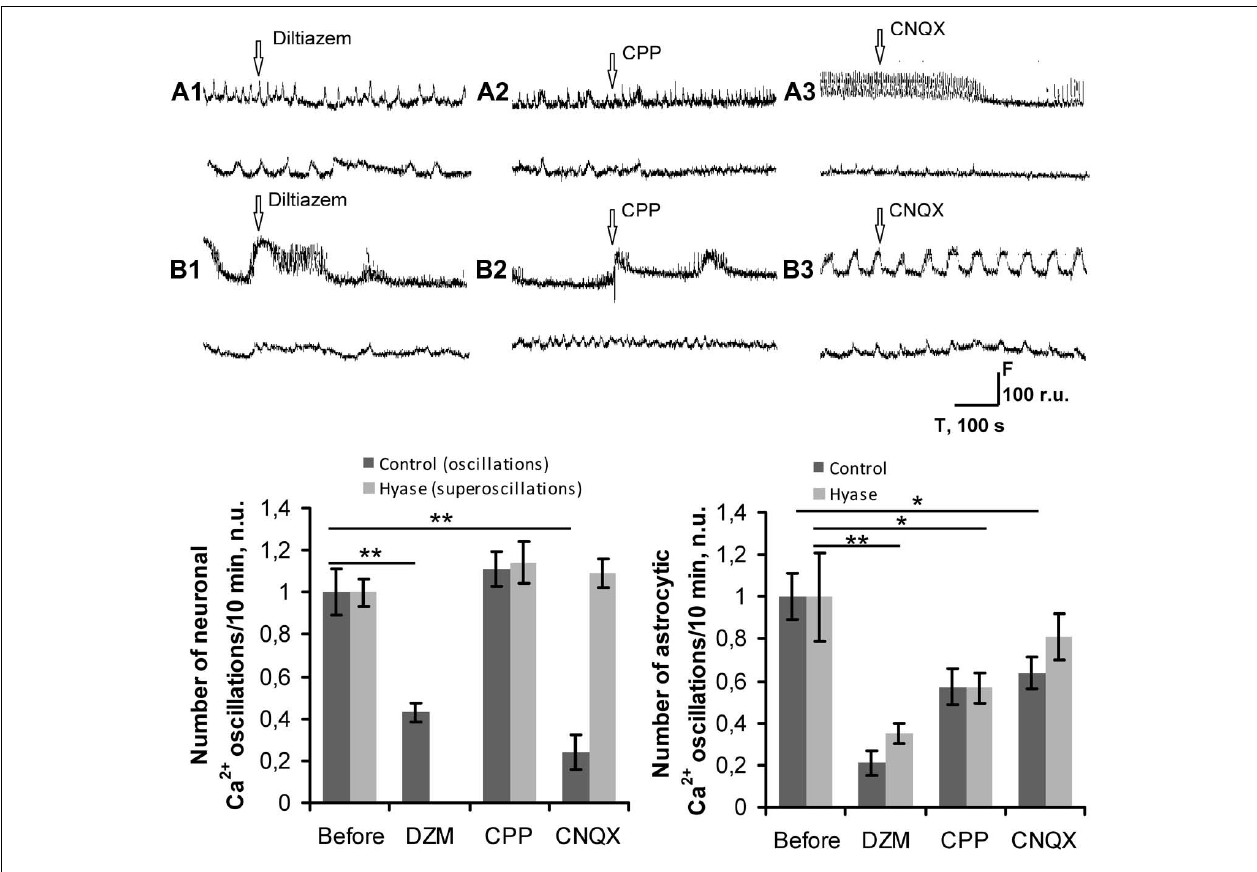
FIGURE 6 | Pharmacological suppression of Hyase-induced long-lasting Ca 2 + oscillations in neuronal networks. (A,B) Spontaneous Ca 2 + oscillations recordings on DIV 26, 5 min after blocker application. Upper curves show neuronal transients, lower curves represent astrocytic transients. (A1) Control group treated with diltiazem; (A2) Control group treated with CPP; (A3) Control group treated with CNQX; (B1) Hyase group treated with diltiazem; (B2) Hyase group treated with CPP; (B3) Hyase group treated with CNQX. (C) Blockage of L-VDCCs decreases the